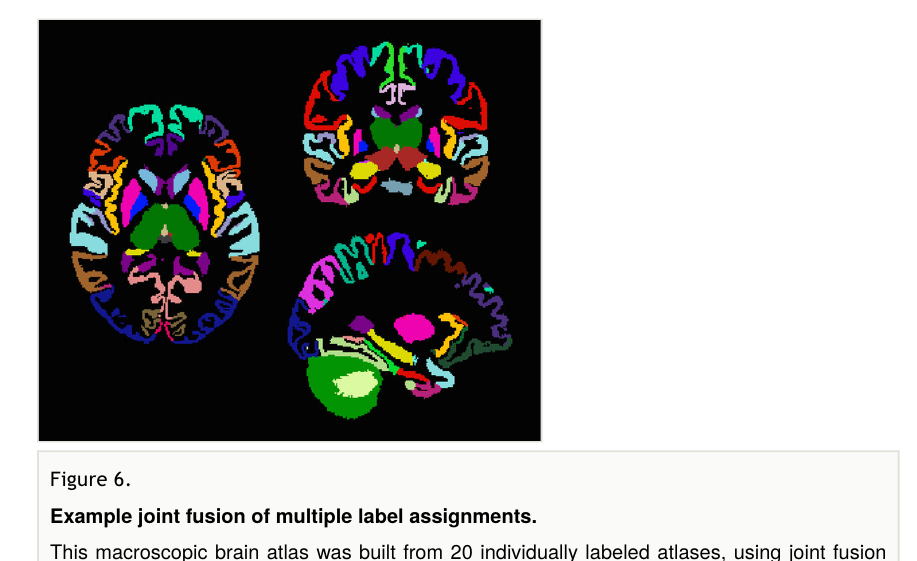
Exploratory Aim 1: Assess the potential for extending the game to all brain regions.